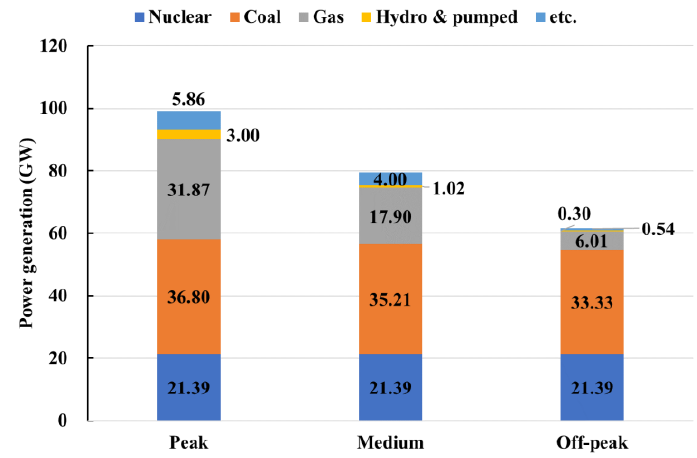
Figure 4. Generation profile in each system operating condition.